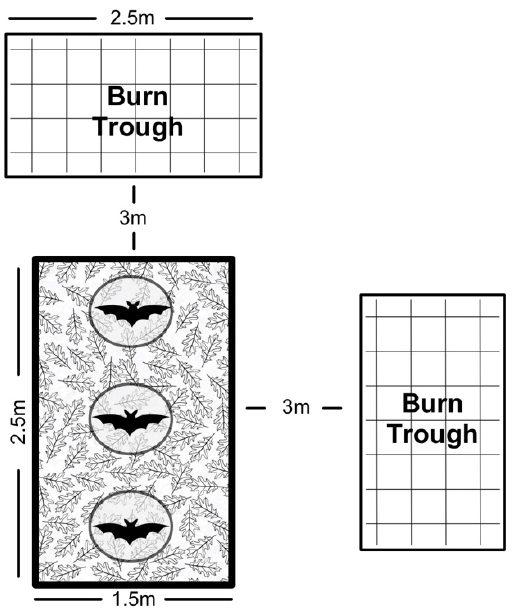
Figure 2. Schematic for field-based trials showing the fabricated forest floor and position of troughs containing leaf litter that was burned to simulate prescribed fire. Individual bats were placed into individual enclosures with leaf litter the night prior to field trials.